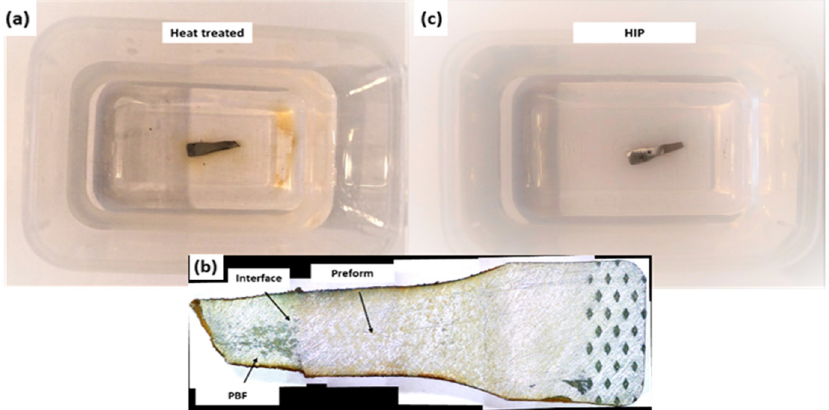
Figure 5. The results of corrosion test for the hybrid samples, ( a ) heat treated sample in its respective testing tray at 36 h, ( b ) heat treated sample with surface corrosion after 36 h, and ( c ) image of HIP sample right after 36 h in the solution.